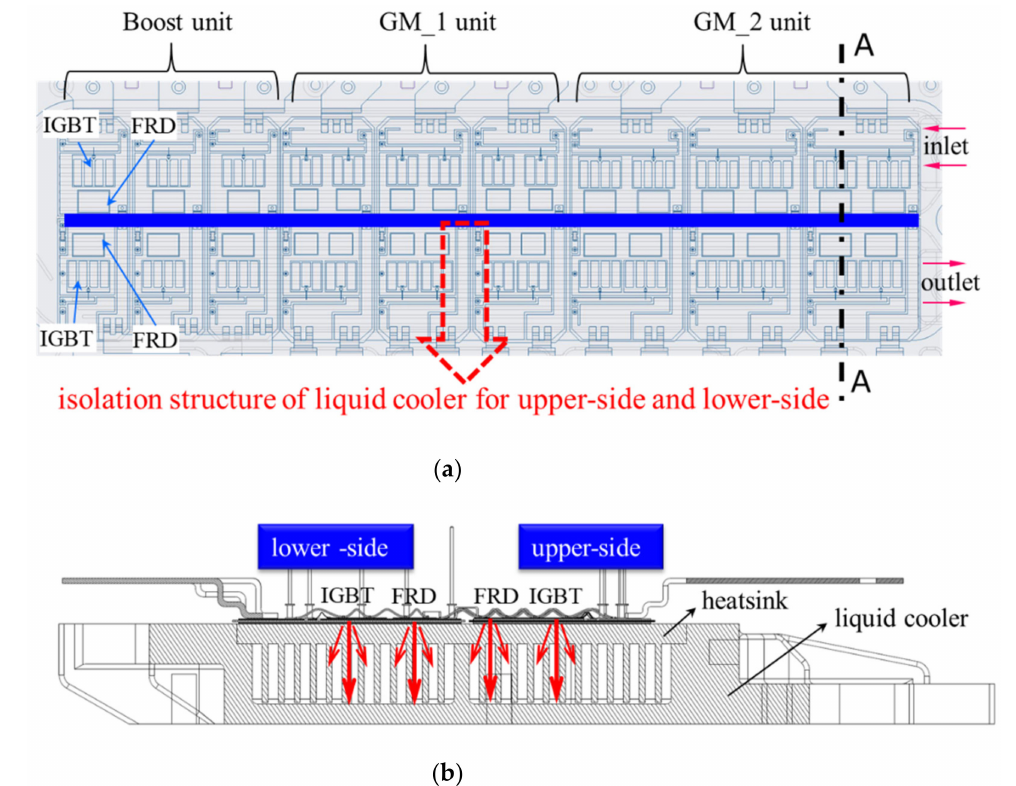
Figure 7. Structural design diagram of the developed PCU module: ( a ) placement design of power dies and ( b ) heat-flow paths for cross section of